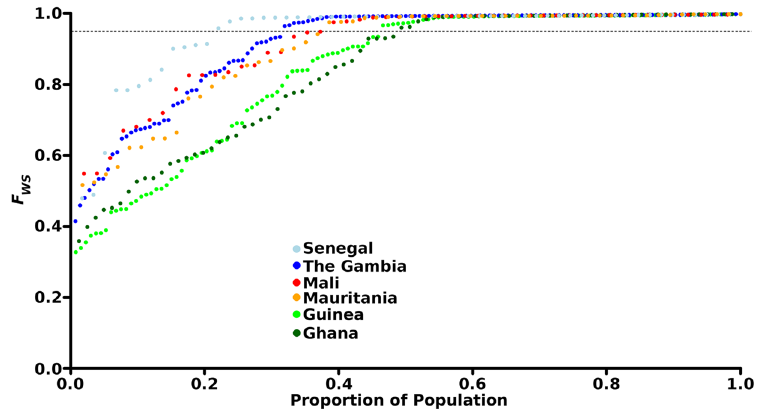
Figure 2. Analysis of genomic diversity within all P. falciparum infection samples analysed from six West African countries using genome wide sequence data. The fixation index F WS is an inverse measure of within- infection diversity compared to the overall diversity in the population, so that a value of 1.0 indicates no variation within an infection, and lower values indicate infections with more diversity. Each point plots the value of an individual infection sample, and for each country the values are plotted in ascending order so that the cumulative proportions may be read along the x-axis. The dashed line corresponds to F WS = 0.95, an arbitrary cut-off measurement above which an infection is considered to be virtually dominated by a single genotype. Mean values for each sampled site are shown in Table 1, and values for all individual infections are given in Table